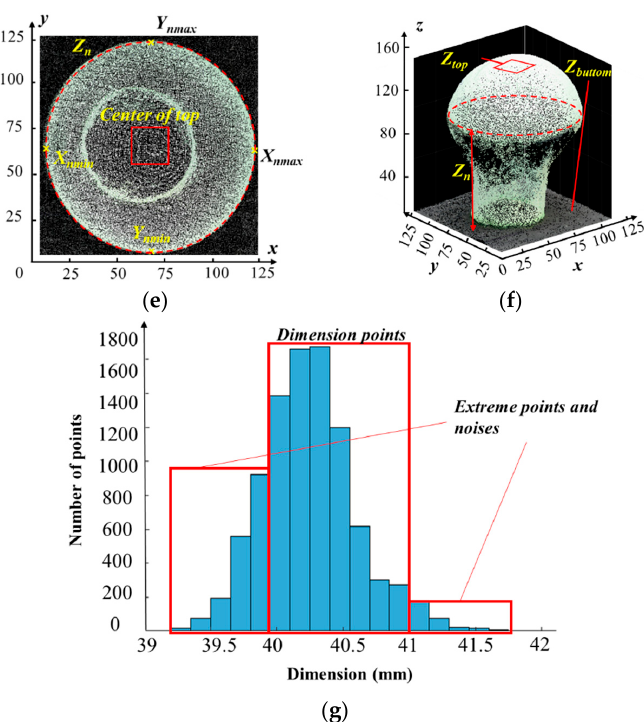
Figure 4. Illustration of the dimension measurement approaches using dense point clouds. Subfigures ( b , d , f ) are the 3D images of O1_1, O2_1 and O3_1, respectively. Subfigures ( a , c , e ) are the projected images in x - y plane and ( g ) shows the way to select dimension points and remove extreme points and noises. The x , y and z dimensional units used in ( a – f ) are mm.